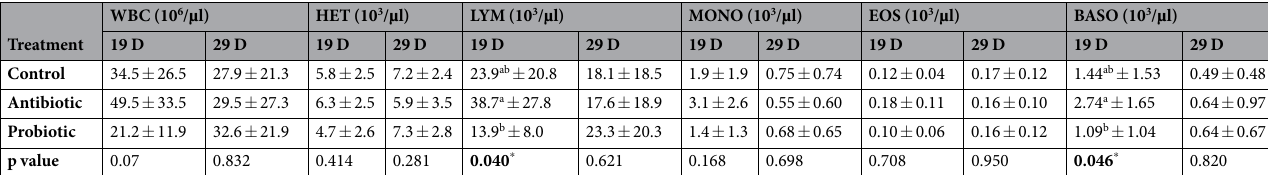
Table 1. Mean ( ± standard deviation) total leukocyte count (WBC) at day 19 and 29, and composition of heterophils (HET), lymphocytes (LYM), monocytes (MONO), eosinophils (EOS) and basophils (BASO) of broilers receiving different treatments. * p < 0.05, a, b Means within columns with different superscripts differ significantly (p <